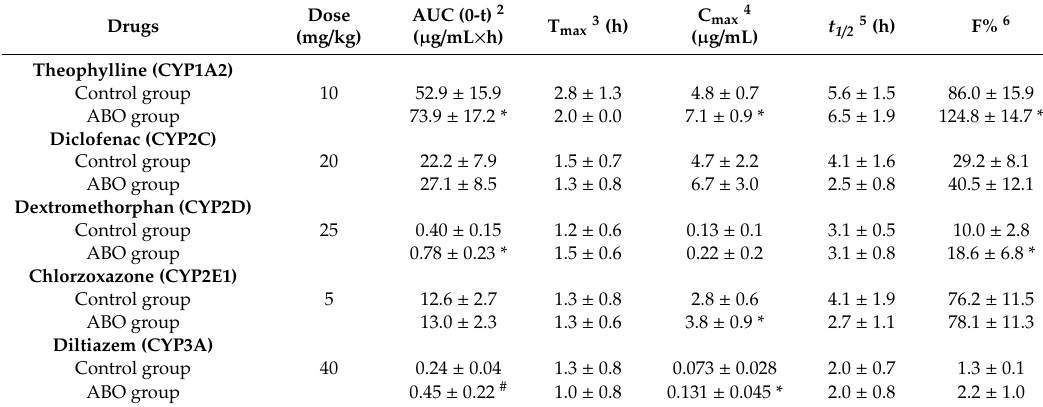
Table 2. Pharmacokinetic parameters of five drugs (PO dosing) after the administration of a single oral dose of ABO in rats 1 .